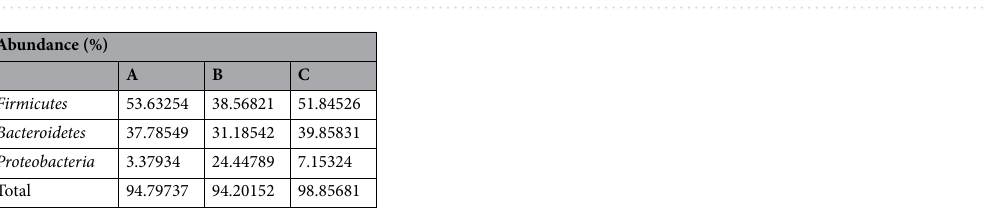
Figure 15. Taxonomic profiles of the fecal bacteria in the four groups at the phylum level ( a ) and genus level ( b ).